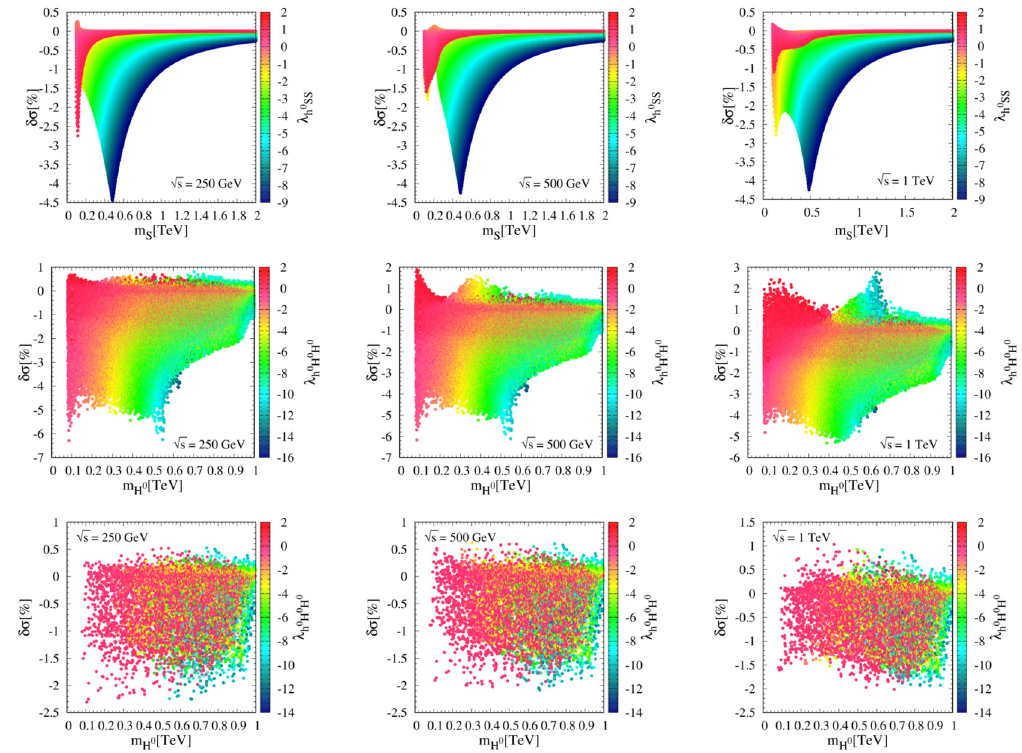
Figure 9 . IHDM corrections to e + e − → Zh 0 as a function of the Higgs masses with triple Higgs couplings λ normalized to the VEV on the vertical color bar for collision energy 250 GeV, h 0 SS 500 GeV and 1000 GeV, respectively. From upper to lower panels, results for Scenario I, II, and III, are shown,